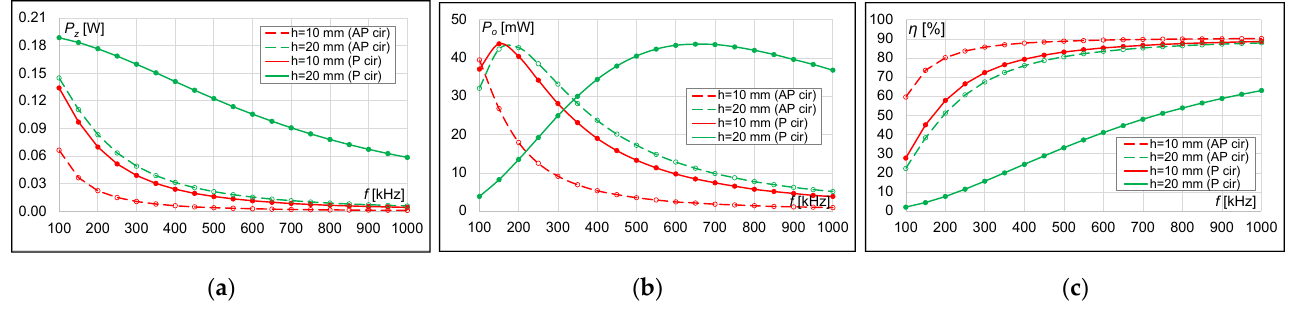
Figure 10. Results for circular coils with r = 20 mm and the number of turns n = 50 at two distances ( h = 10 mm and h = 20 mm): ( a ) transmitter power, ( b ) receiver power, ( c ) power transfer efficiency.